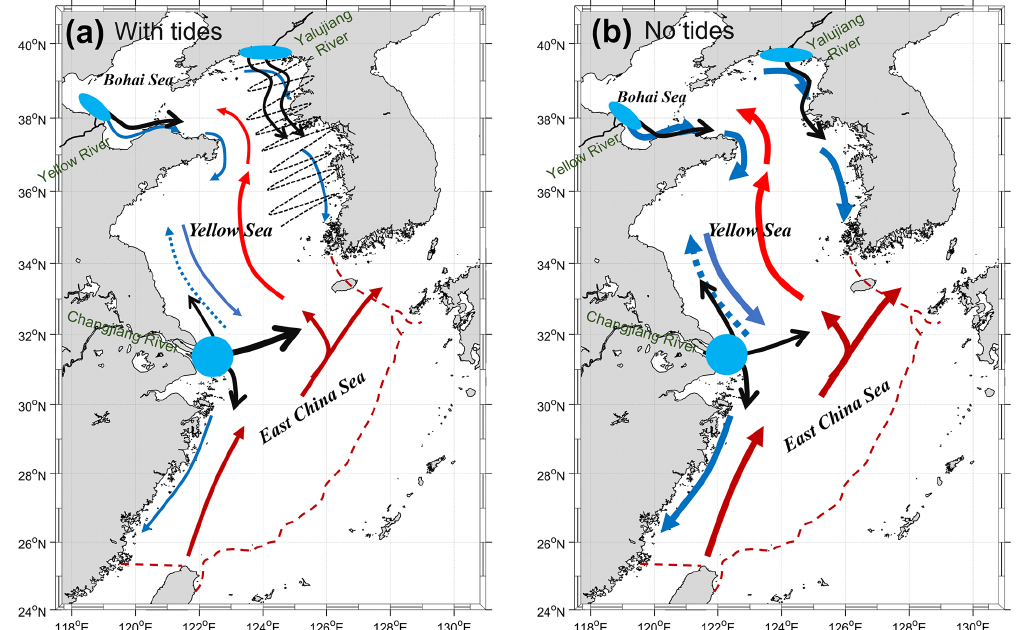
Figure 11. Schematic map of the shelf currents and the major pattern of the river water transport for the control run (a) and no-tide case (b) . The blue and red arrows denote the coastal currents and warm currents, respectively. The blue dashed arrow at the Jiangsu coast denotes the coastal current in summer. The thickness of the arrows denotes the intensity of the shelf currents. The black dashed wavy line in (a) denotes the cross-shelf dispersion induced by tides. The black arrows denote the direction and the branches of the river water